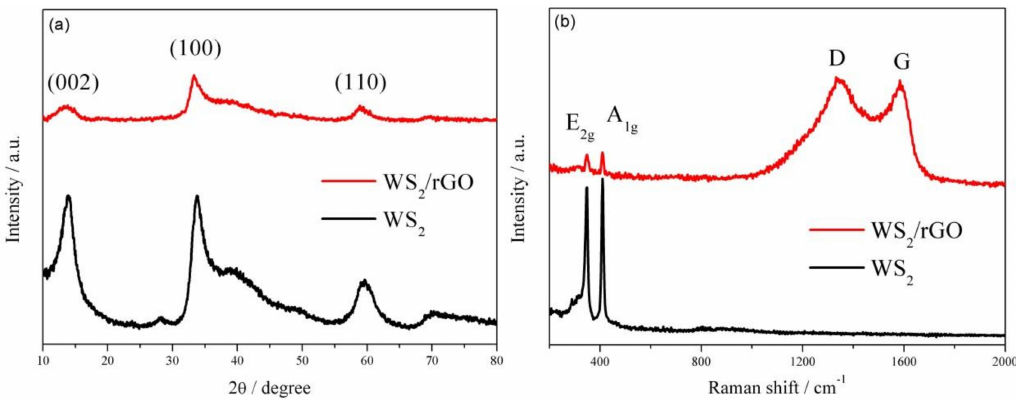
Figure 2. ( a ) XRD patterns and ( b ) Raman spectra of WS 2 and WS 2